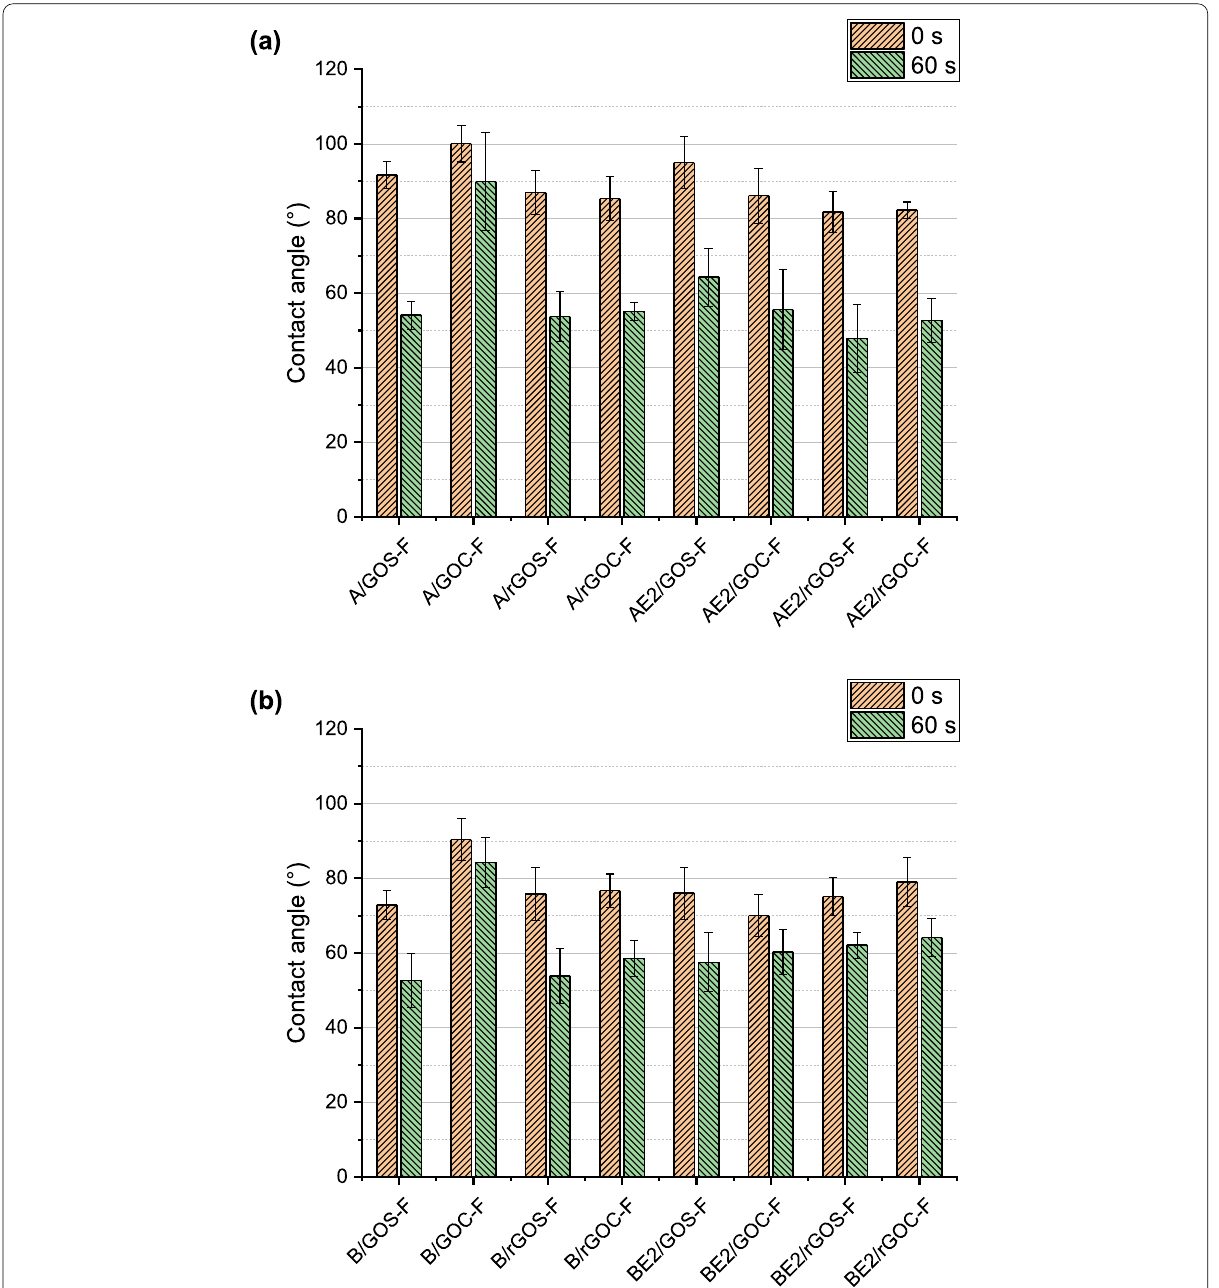
Fig. 7 Contact angle values at 0 s and 60 s for the different a chitosan and b chitosan/carboxymethyl cellulose (CMC)-based nanocomposite films. The error bars indicate standard